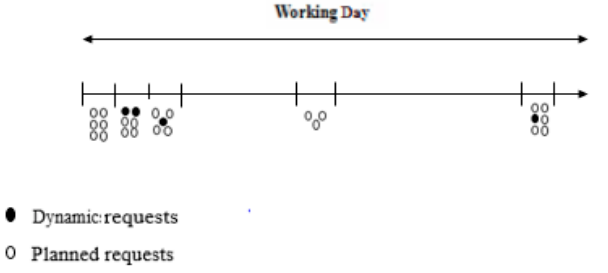
Figure 3. The division of the working day.